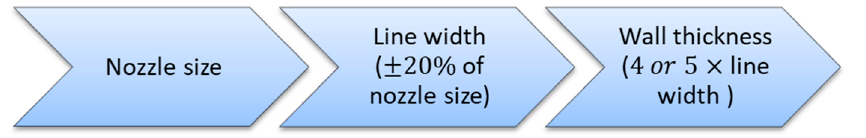
Figure 16. Tip position, here it is possible to see the tip movements in 2D space for R-type with 1.6 and 1 mm wall thickness.